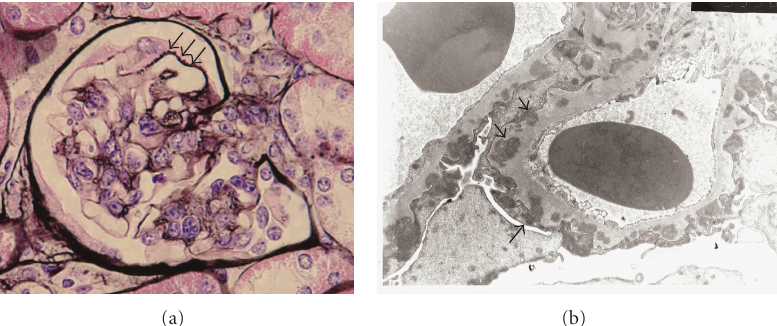
Figure 4: MRL/ lpr mice disrupted the WSX-1 gene developed disease essentially identical with human MLN. (a) A representative glomerulus of 36-week-old WSX-1 − / − MRL/ lpr mouse (x400, PAM staining). Arrows indicate spike formation. (b) Electron micrograph (x4000) of the glomerular capillary of the mouse shows numerous subepithelial electron-dense deposits in the basement membrane (arrows).